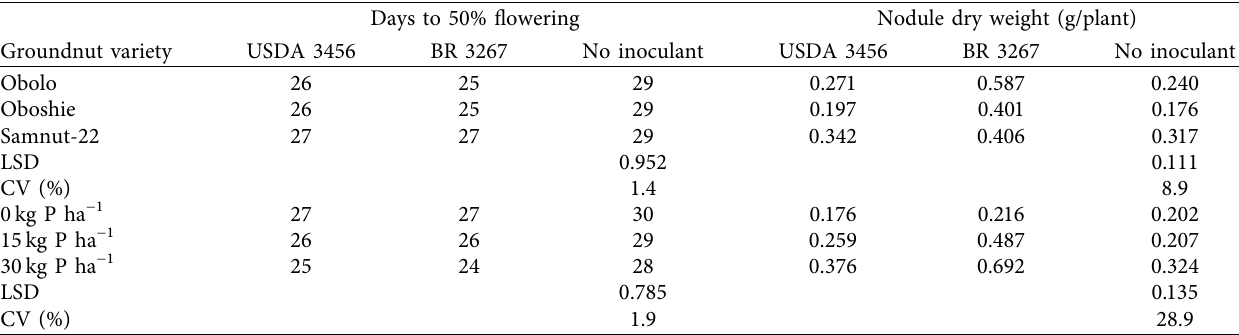
Table 2: Influence of rhizobium inoculants and phosphorus fertilizer on days to 50% flowering and nodule dry weight of three groundnut varieties.